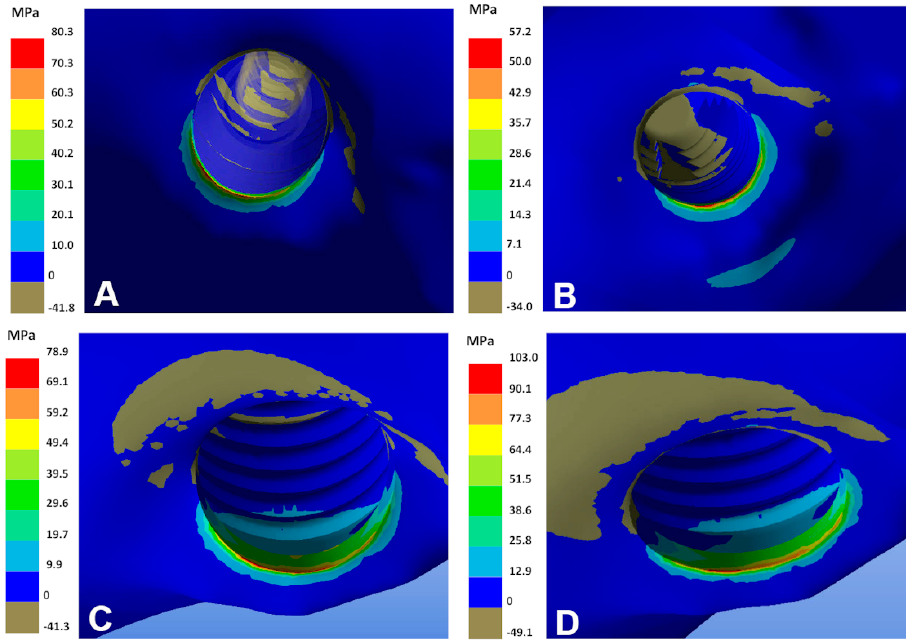
Figure 2. Maximum principal stresses in the bone of the different models. ( A ) Ti–6Al–4V; ( B ) Ti– 26.88Fe–4Ta; ( C ) Ti–15Zr; ( D ) Ti–13Nb–13Zr.